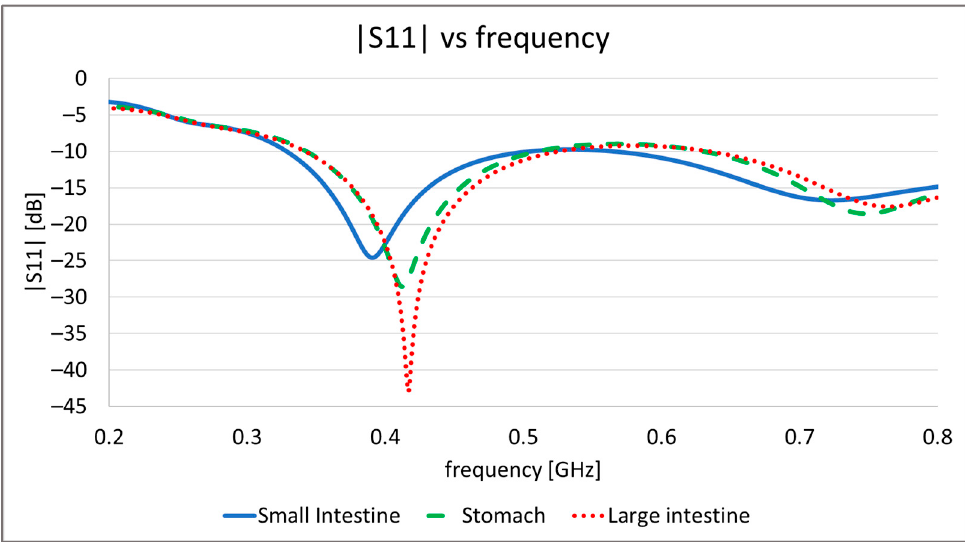
Figure 9. Impedance matching of the capsule